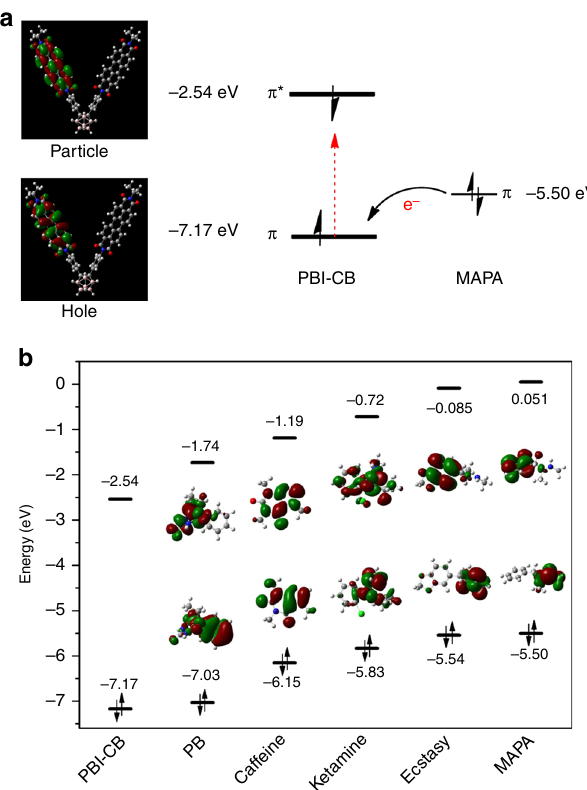
Fig. 6 DFT calculations of PBI-CB and the drugs. a The electron density distributions of the fl uorescence emission relevant orbitals of PBI-CB, and possible quenching mechanism in the presence of the tested illicit drugs. b Dominant natural transition orbital pairs for the lowest singlet excited state geometry, and levels of HOMO ( π ) and LUMO ( π *) orbitals of PBI-CB as well as the relevant illicit